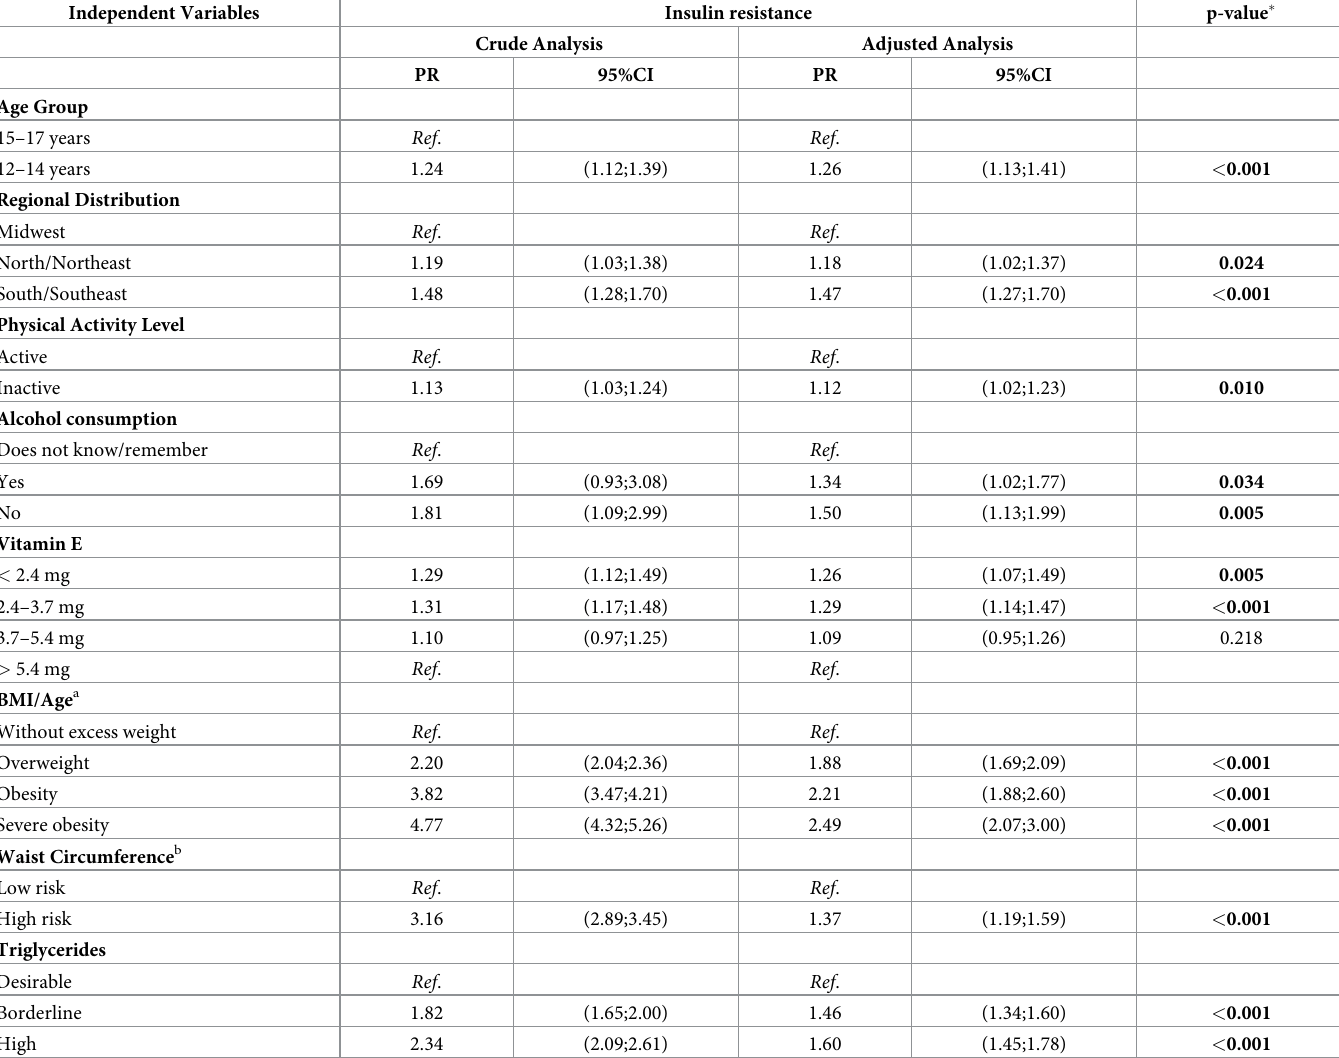
Table 7. Crude and adjusted prevalence ratios for effects of explanatory variables on insulin resistance in Brazilian adolescents. ERICA Study, 2013–2014. Independent